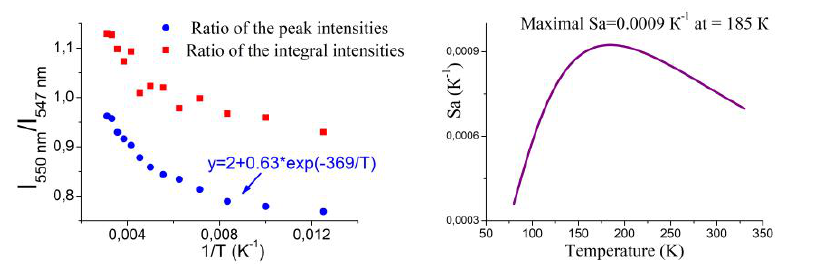
Fig.2 . The luminescence intensity ratio for Pr 3+ :LiYF 4 nanoparticles (a), absolute temperature sensitivity as function of